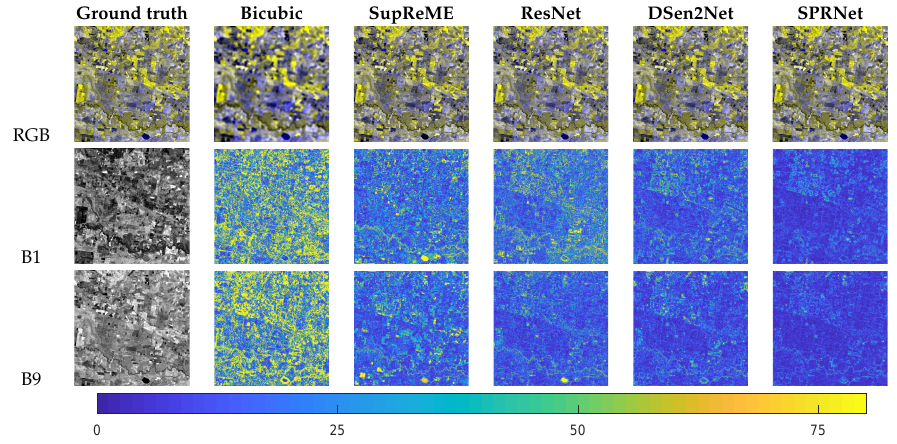
Figure 8. Absolute differences between ground truth and sharpening results on site 2 at lower scale (input 360 m output 60 m). (input 360 m output 60 m).